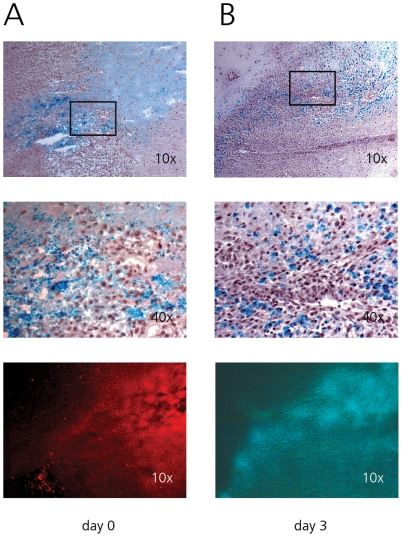
CED of trypan blue, SPIO and adenovirus targeting infiltrative C6 tumors.When tumor infiltrated the white matter, iron particles are seen engulfing tumor cells. Penetration into solid tumor is limited either with SPIO (top two rows), trypan blue (A, bottom row) or adenovirus infusion (B, bottom row). Bottom row trypan blue and GFP images correspond to top row Perls stained images. (A) Iron and trypan blue distribution directly after infusion. (B) Iron and GFP distribution three days after infusion.